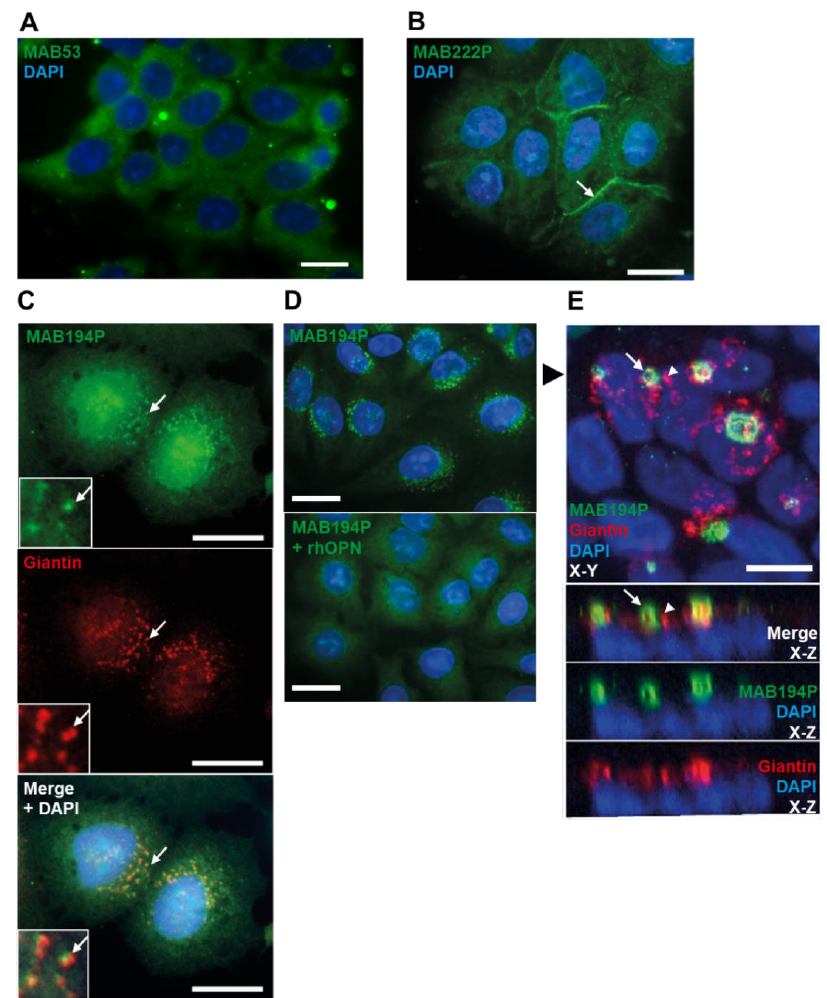
Figure 2. ( A,B ) Sub-confluent Ishikawa cells immunostained with MAB53 or MAB222P respectively. 20µm scale bar. ( C ) Sub-confluent Ishikawa cells co-immunostained with MAB194P (green) and anti-giantin antibody (red). Arrows indicate colocalised puncta. Scale bars are 20 µm. ( D ) Sub-confluent Ishikawa cells immunostained with MAB194P or MAB194P pre-incubated with rhOPN. Scale bars are 20 µm. ( E ) Confluent Ishikawa cell layer co-immunostained with MAB194P (green) and anti-giantin (red). Upper panel is maximum intensity projection of 33 0.24 µm-interval optical sections. Lower panels are Z-plane stacks of optical sections. The black arrowhead in the upper panel indicates the slice of the Z-plane stack. White arrows indicate MAB194P-positive structures and white arrowheads indicate giantin-positive structures. Scale bars are 10 µm.